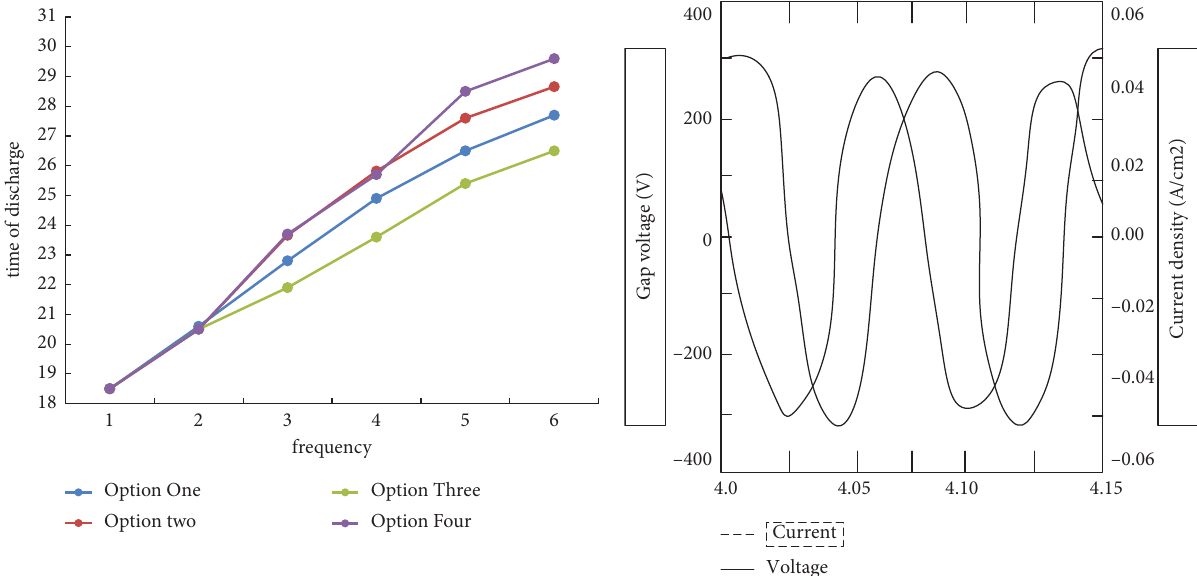
Figure 7: Data analysis of discharge experiment.